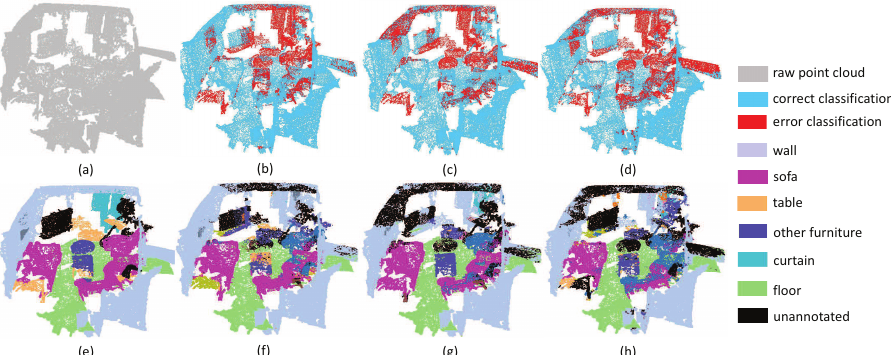
Figure 11. The complex scene segmentation results on LivingRoom 1. ( a ) input, ( e ) ground truth, ( b , f ) the classification result by PointNet++, ( c , g ) the classification result by PointSIFT, and ( d , h ) the classification result by SAN.